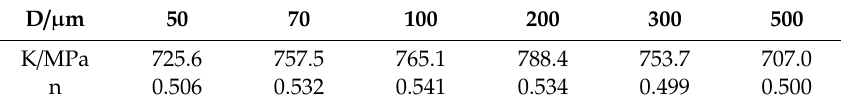
Table 2. Values of k and n obtained through